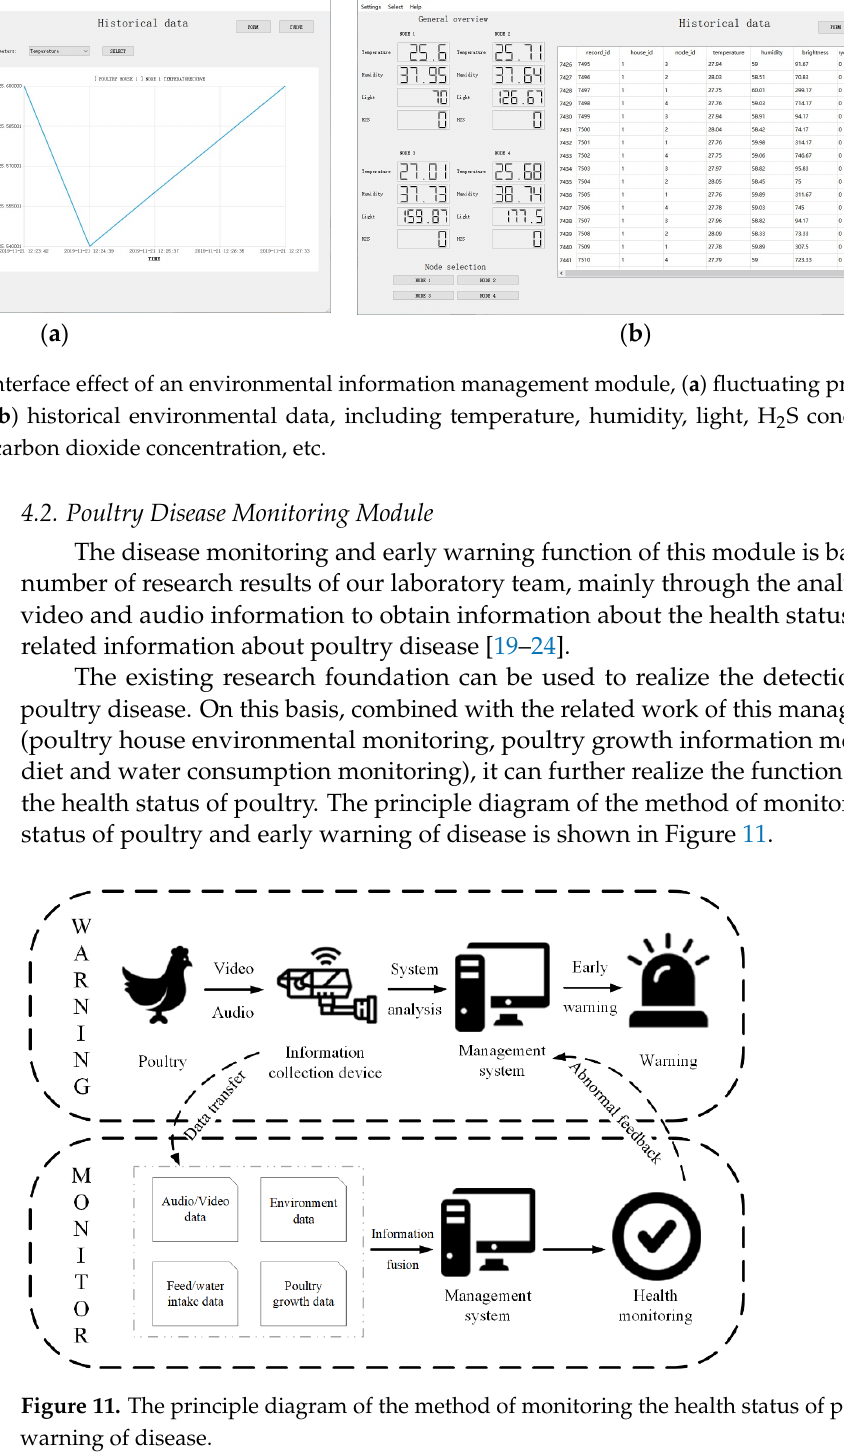
Figure 9. The business process chart of environmental information management module. EISU means environmental information sensing unit.